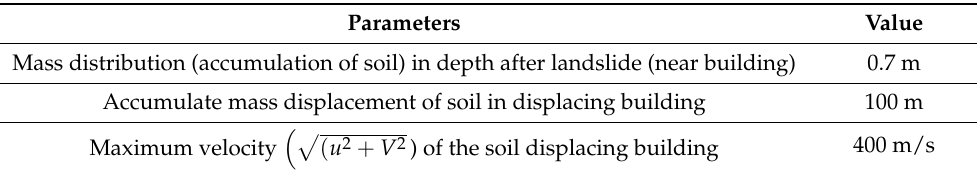
Table 4. Effect of soil in building collapse (from LS RAPID).